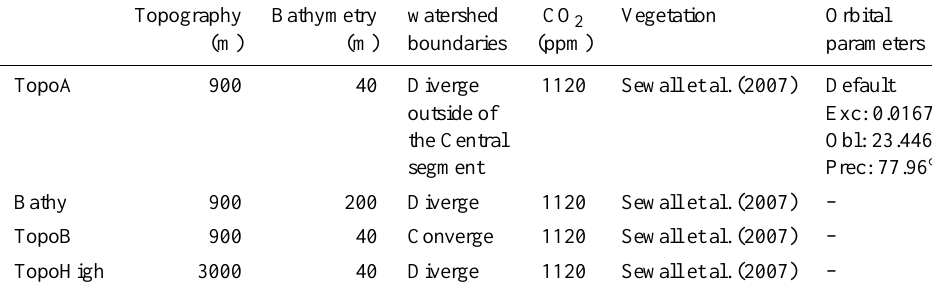
Table 1. Description of the different